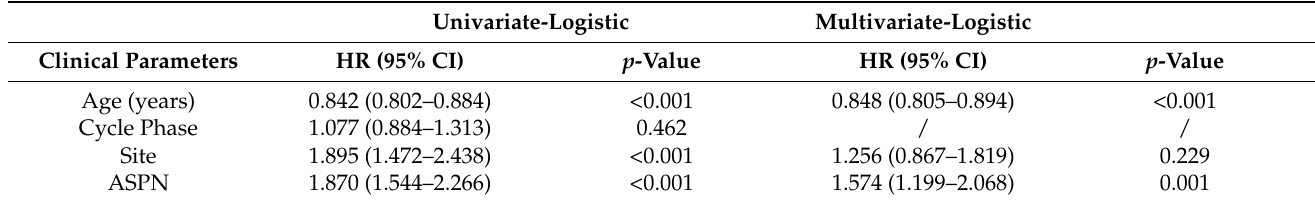
Table 5. Logistic regression to determine the effect of different clinicopathological factors on the expression of ASPN gene and clinical prognosis in